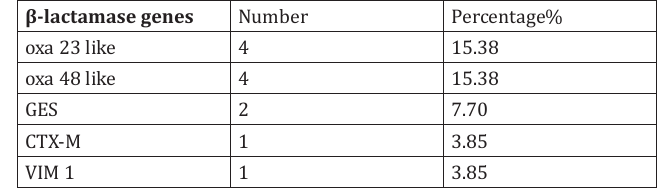
Antibiotic susceptibility test result of Proteus mirabilis and Enterobacter cloacae isolate